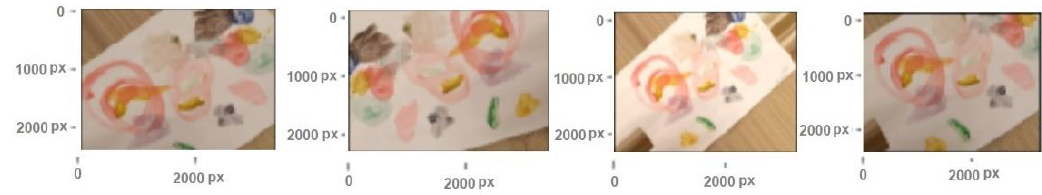
Figure 2. Drawing without the augmentation.